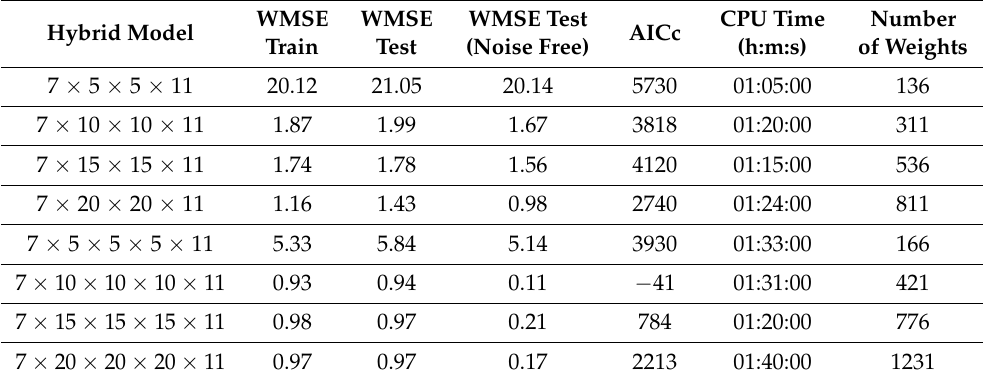
Table 4. Training metrics of different hybrid models for the yeast glycolytic oscillations case study (Dano1). The dataset was divided into four experiments for training (400 training examples for each state variable) and five for testing (500 testing examples for each state variable). The training was performed with ADAM with default hyperparameters as suggested by Kingma (2014) ( α = 0.001, = 0.9, = 0.999 and ζ = 1 × 10 − 8 ). The number of iterations was 10000. The minibatch size was 78% and weight dropout probability was 0.22 as suggested by Pinto et al. (2022). The AICc was computed on the training set only. The noise-free WSSE measures the error between noise-free data (e.g., true process behavior) and model